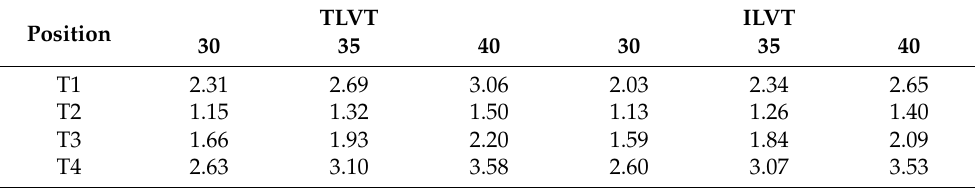
Table 10. Stress value at No. 11 loading point under lateral and vertical coupled load